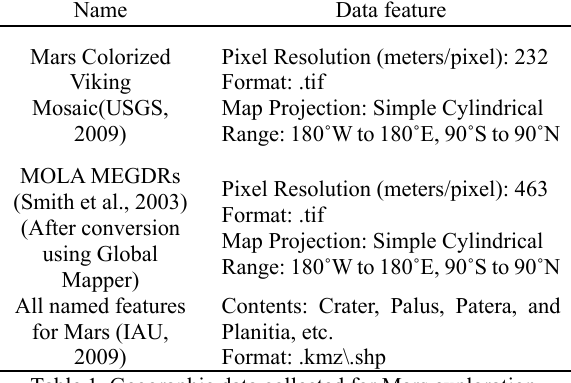
Table 1. Geographic data collected for Mars exploration simulation using Sino-Mars